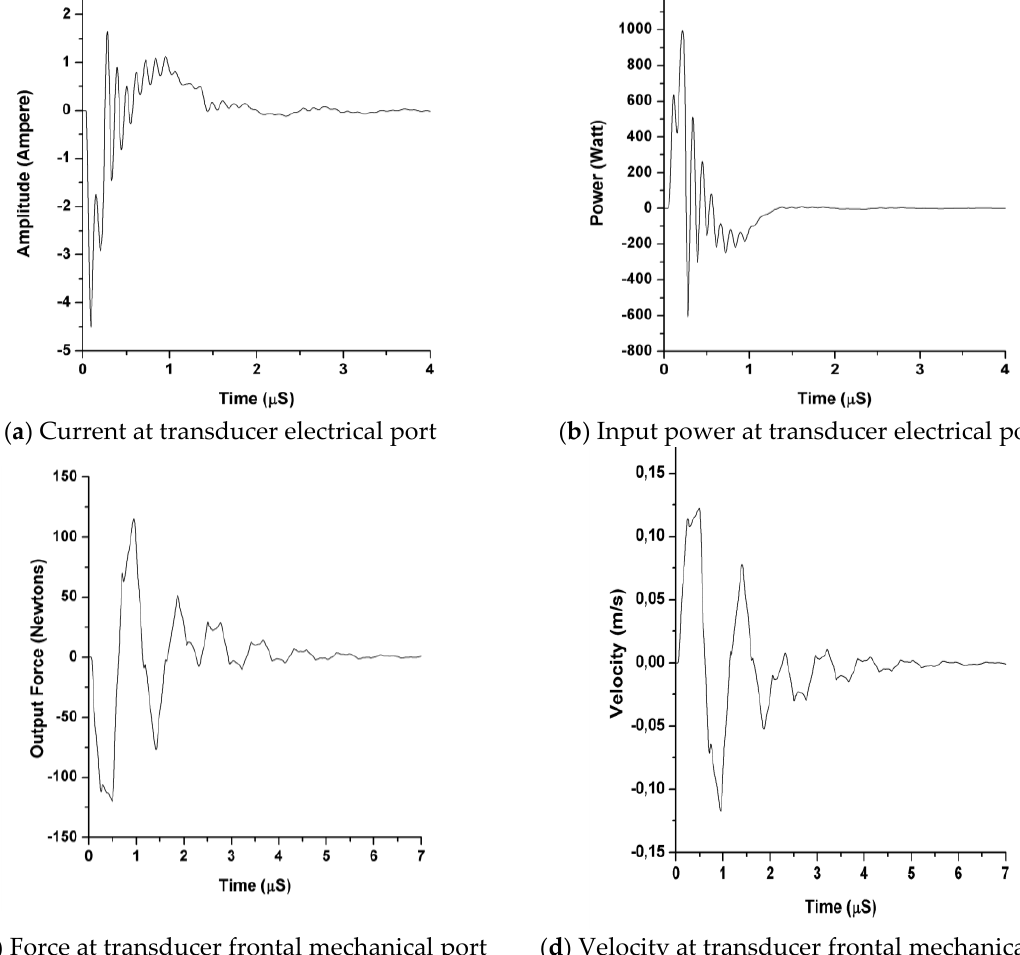
Figure 11. Output current ( a ) and power ( b ) waveforms simulated for our tuned HV capacitive driver loaded with the Q269 transducer, using our circuital models of Figure 7. Resulting force ( c ) and velocity ( d ) pulses, calculated for the transducer face emitting on a methacrylate (PMMA) plastic medium.